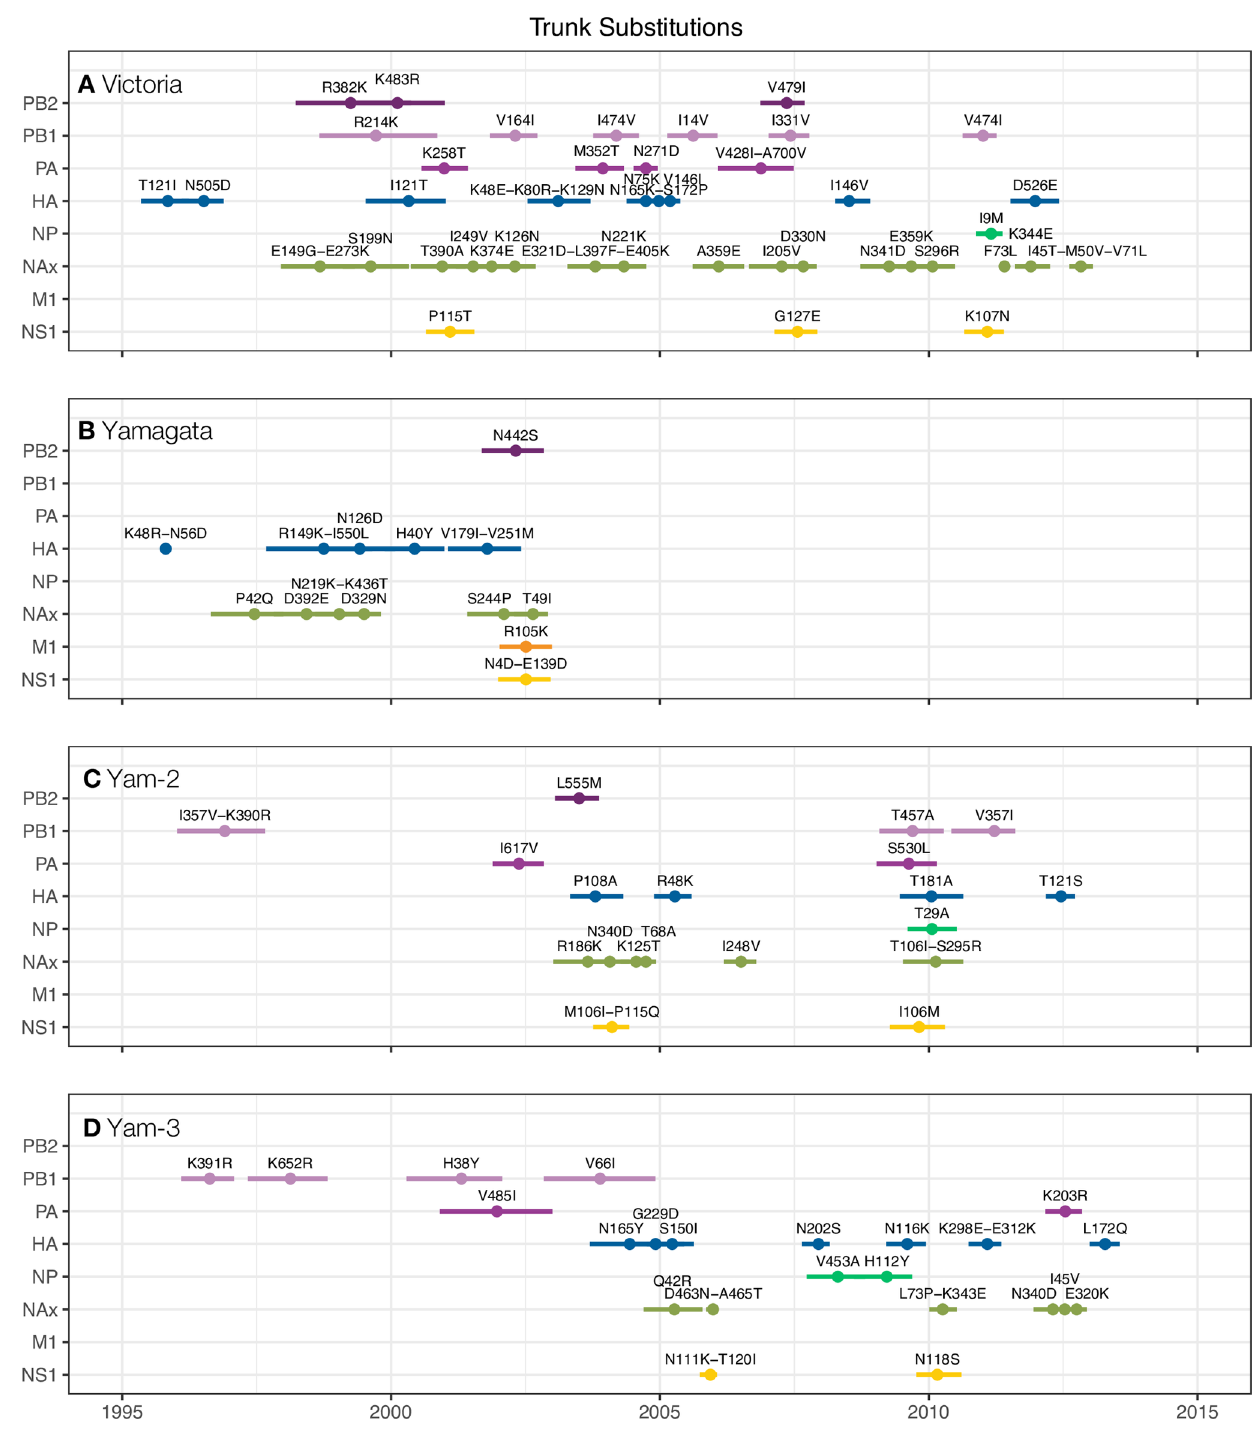
Fig 5. Estimated emergence of nonsynonymous substitutions along the major trunk lineage of the gene phylogenies of Victoria- and Yamagata- lineage virus. Substitutions are summarized from S1 Fig for (A) Victoria-lineage, (B) Yamagata-lineage, (C) Yamagata-lineage clade 2 (B/Massachusetts/02/ 2012 clade), and (D) Yamagata-lineage clade 3 (B/Wisconsin/1/2010 clade), with only substitutions emerging after 1995 shown for clarity. Circles represent median and lines represent 95% HPD estimates of time of emergence across 1,000 posterior trees.